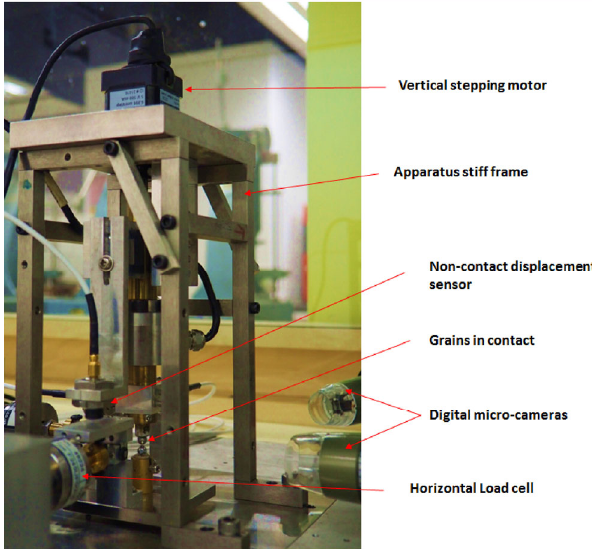
Fig. 3 The existing small-size micromechanical loading apparatus at City University of Hong Kong (frame width equal to 10 cm).